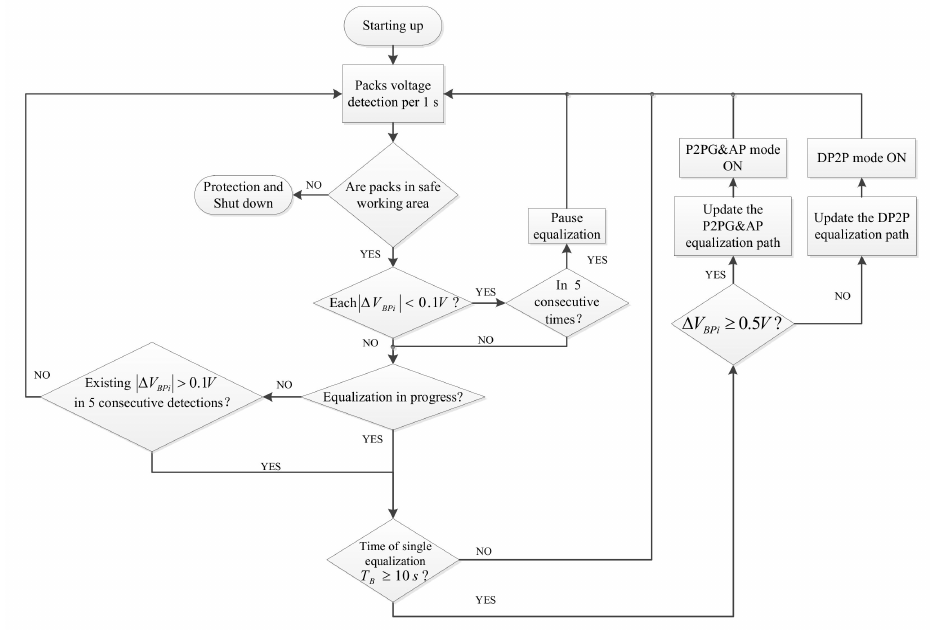
Figure 6. The bimodal hybrid control strategy of proposed pack